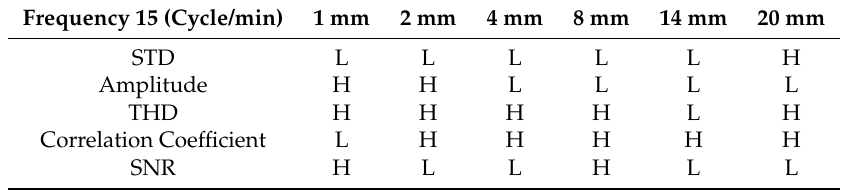
Table A8. Values higher and lower than the median Frequency 15 cycles/min for a 3 mm band.